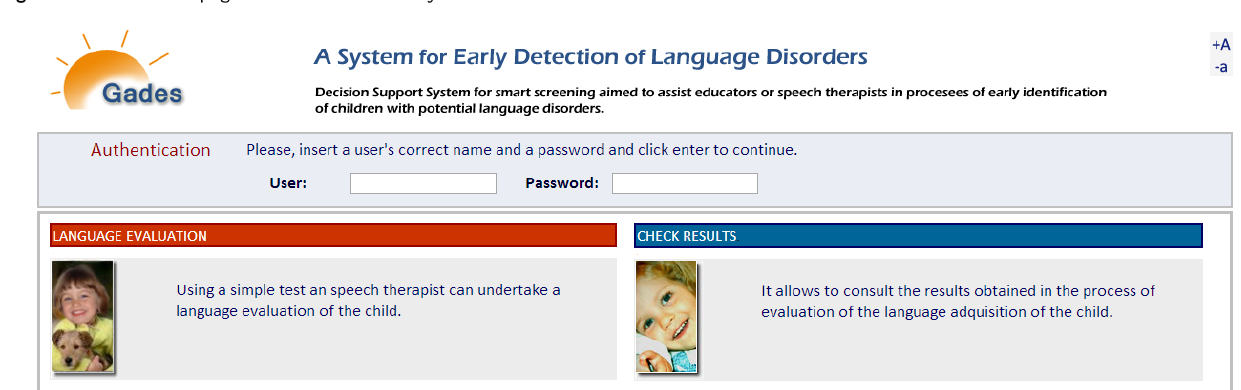
Figure 1. Gades home page and main